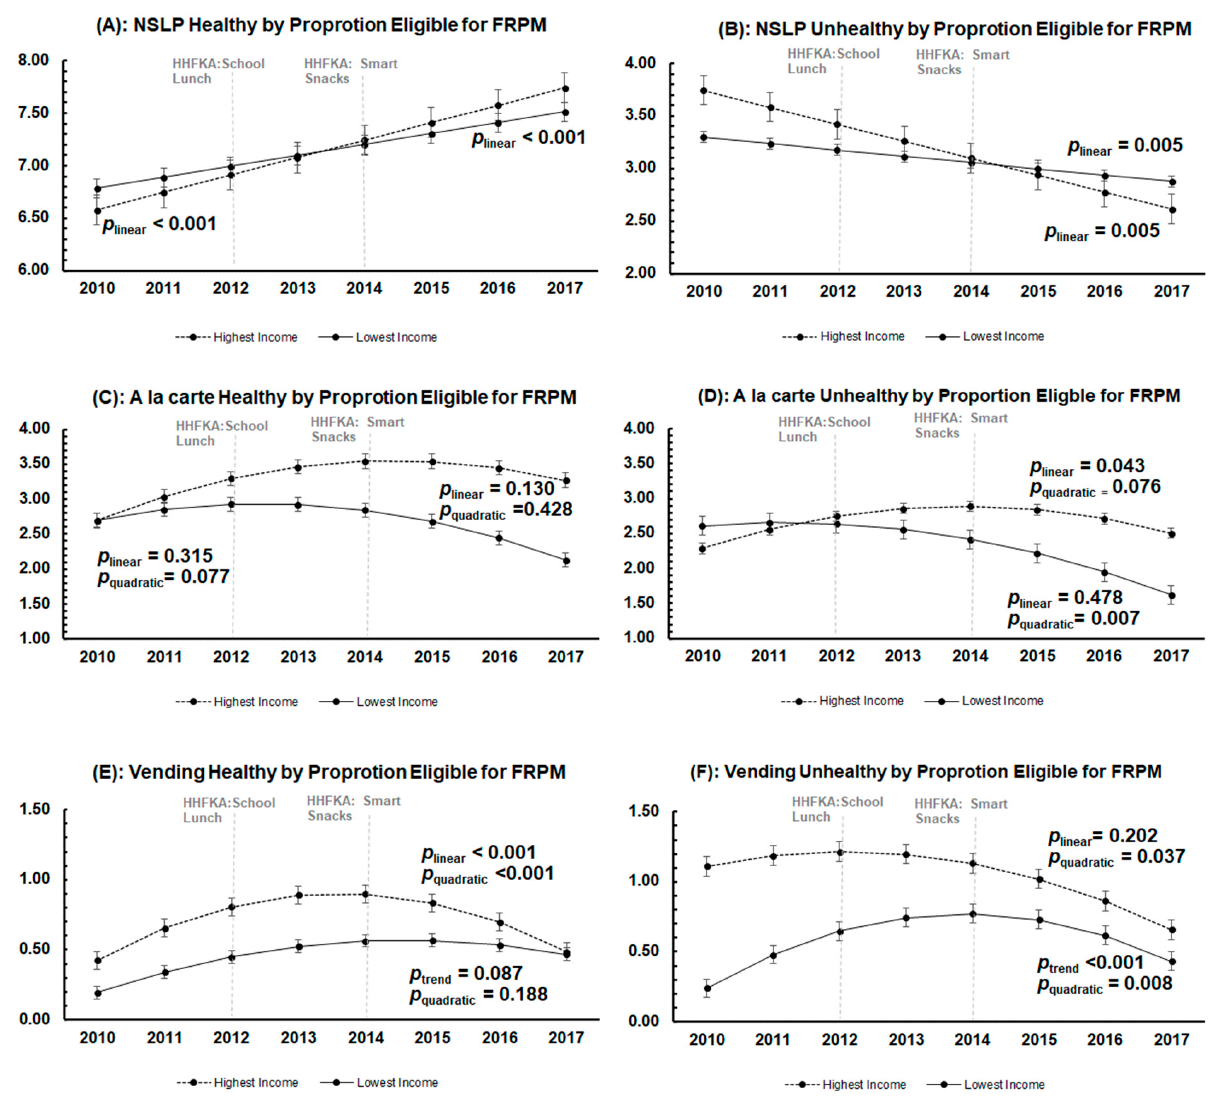
Figure 3. Year-by-year point estimates and predicted trends of each of the six food environment indices from school year 2010-11 to 2017-18 by proportion of students eligible for FRPMs. Dots represent the adjusted point estimates with confidence intervals estimated from the multilevel multivariable linear regression model. Lines represent the predicted line of best fit over the study period. The 2012 vertical line represents the implementation of the Healthy Hunger-Free Kids Act (HHFKA) guidelines for NSLP that occurred in 2012. The 2014 vertical line represents the implementation of the Smart Snacks guidelines (within the HHFKA) that occurred in 2014. When stratified by school level, trends in the availability of foods in each of the three venues approximately mirrored those of the full sample for both elementary and secondary schools (Figure 4A–F). Trends did not vary by school level for any of the